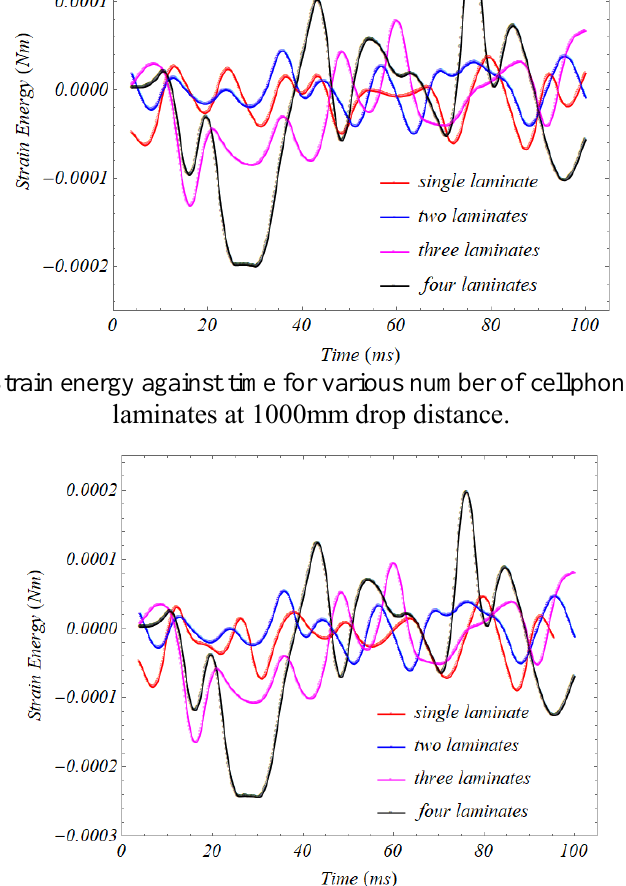
Fig. 9. Strain Energy against time for various number of cellphone casing laminates at 1500mm drop